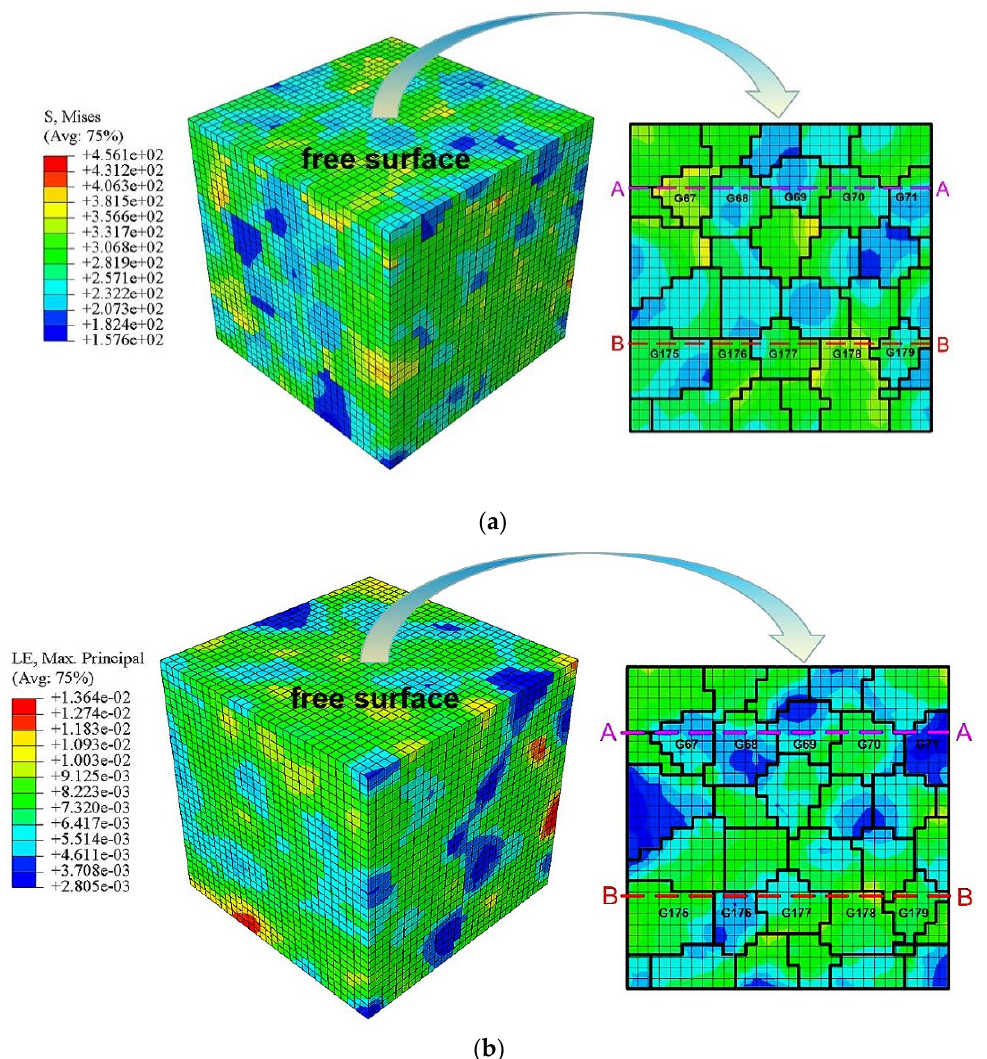
Figure 11. Contours of ( a ) Mises and ( b ) LE maximum principal strain for the whole RVE and its free surface.